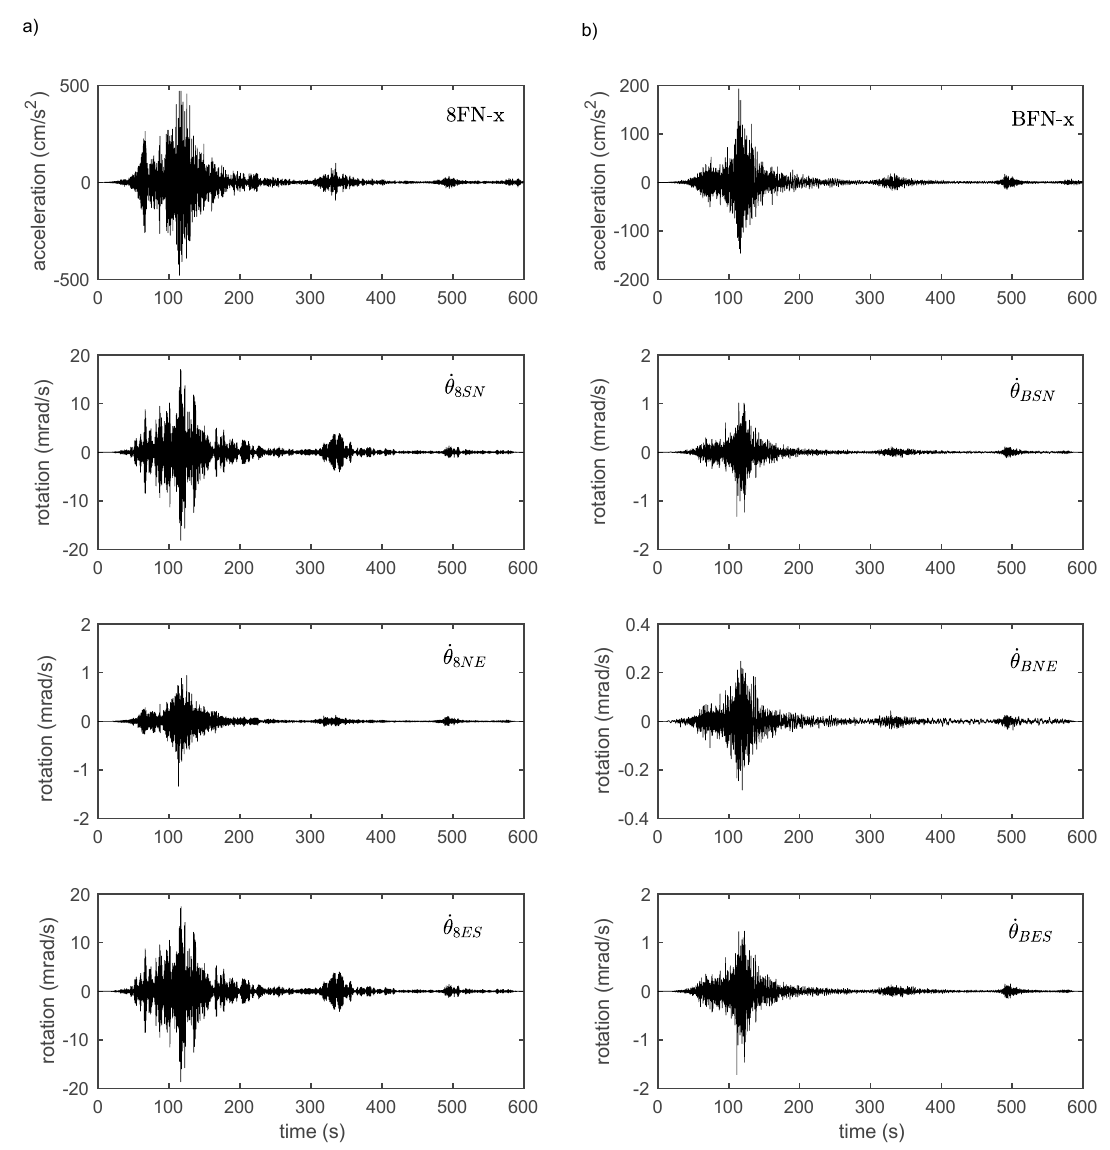
Figure 4. —Example of translational motion recorded during the 2011 Mw 9.0 Tohoku (Japan) earthquake and the array- derived rotational motion ( a ) at the top and ( b ) at the bottom of the ANX building.